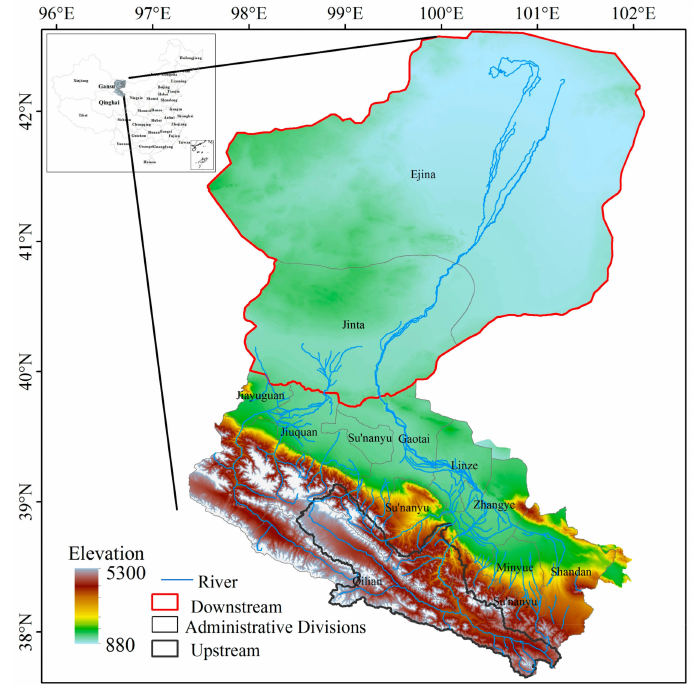
Figure 1. Map of the study